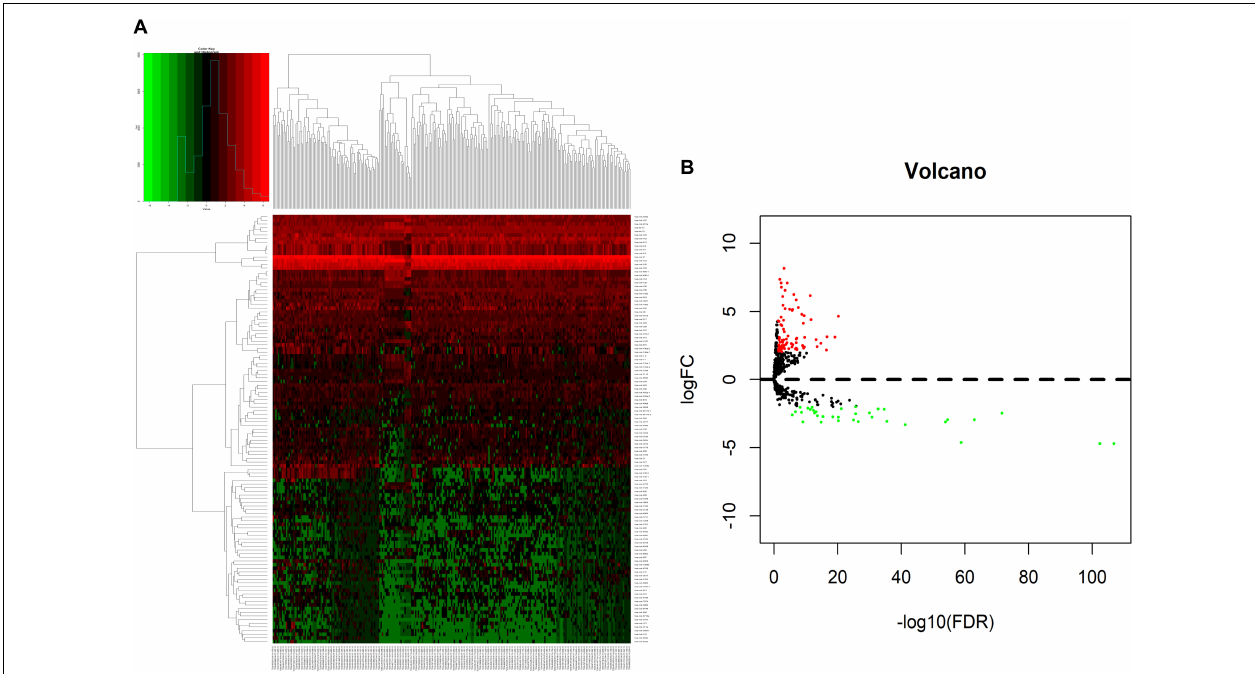
FIGURE 2 | Identification of differentially expressed miRNAs in LUAD and normal tissues. (A) The heatmap of genome-wide differentially expressed miRNAs. (B) The volcano plot showed that a total of 82 upregulated miRNAs and 35 downregulated miRNAs were screened out. Green and red represents downregulated and upregulated miRNAs, respectively. miRNAs, microRNAs; LUAD, lung adenocarcinoma.